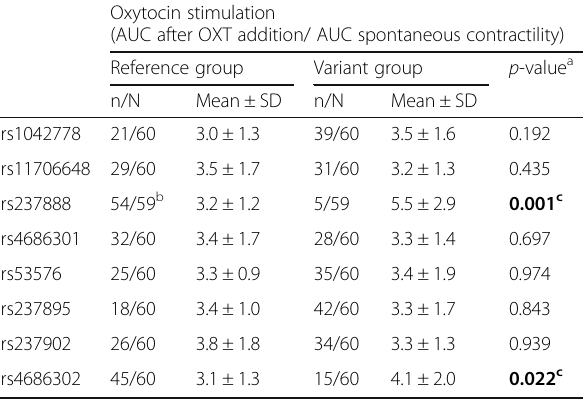
Table 3 Oxytocin stimulation a of myometrium contractility in the various reference and variant allele